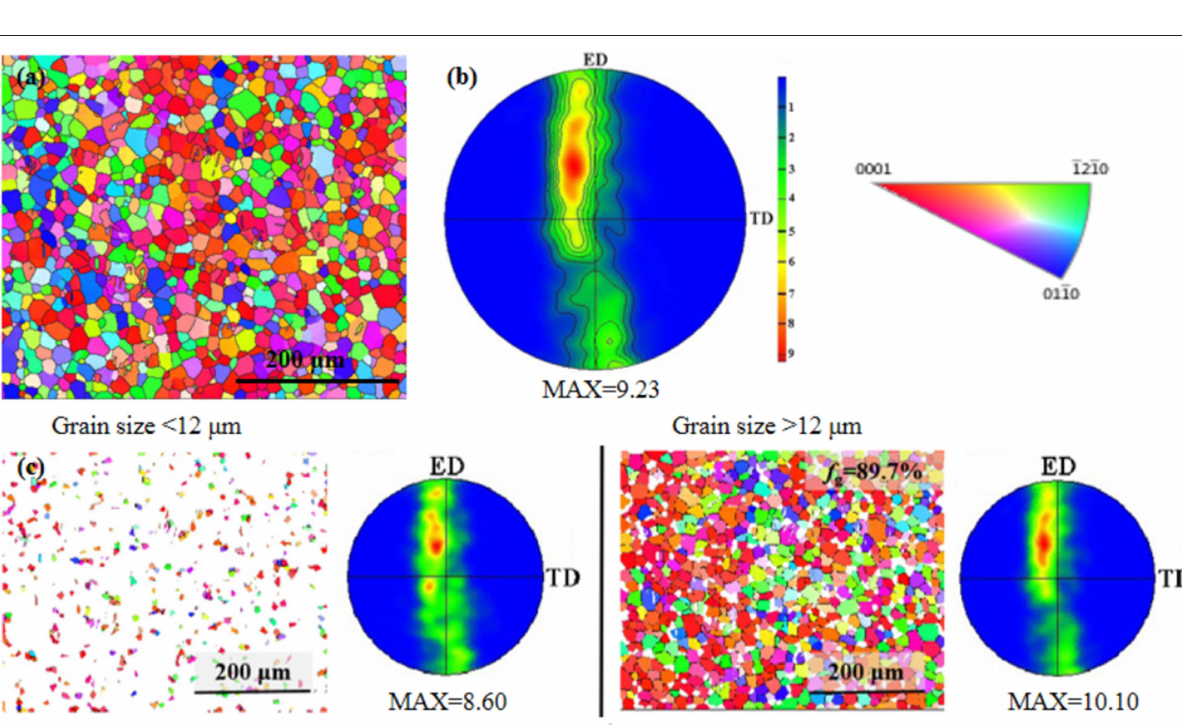
on θ = d σ , where σ and ε are the true stress and d ε strain, respectively, for the extruded dilute TMX-1.0 alloy. By taking the natural logarithms of both sides of the Hollomon equation, the work-hardening exponent can be obtained. The calculated result is 0.13 for the studied alloy. Generally, a higher to strain localization, i.e., a greater EL (Tang et al., 2011; Zhao et al.,